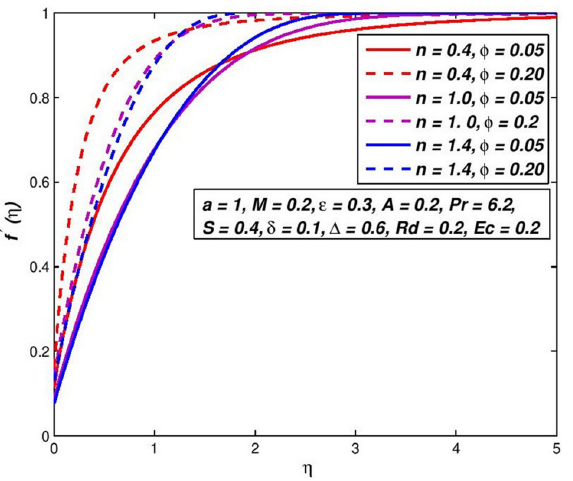
Fig 10. Effect of ϕ on f 0 ( η ) for diverse n